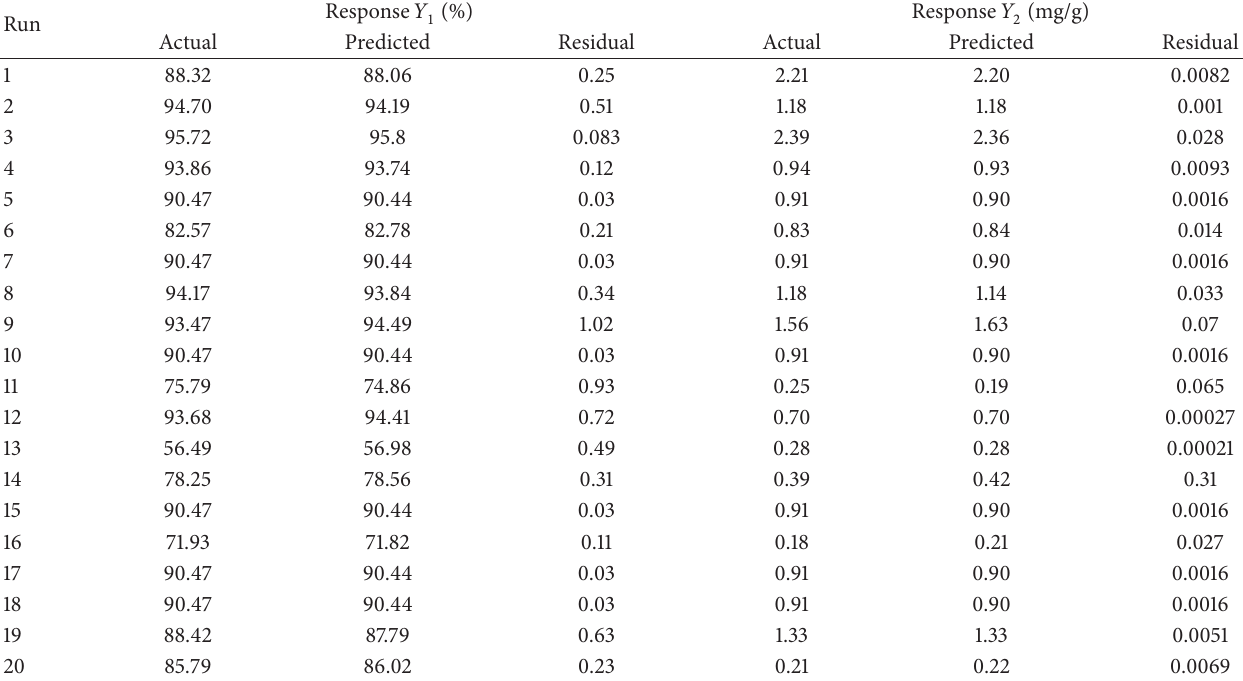
Table 6: Actual-predicted values and